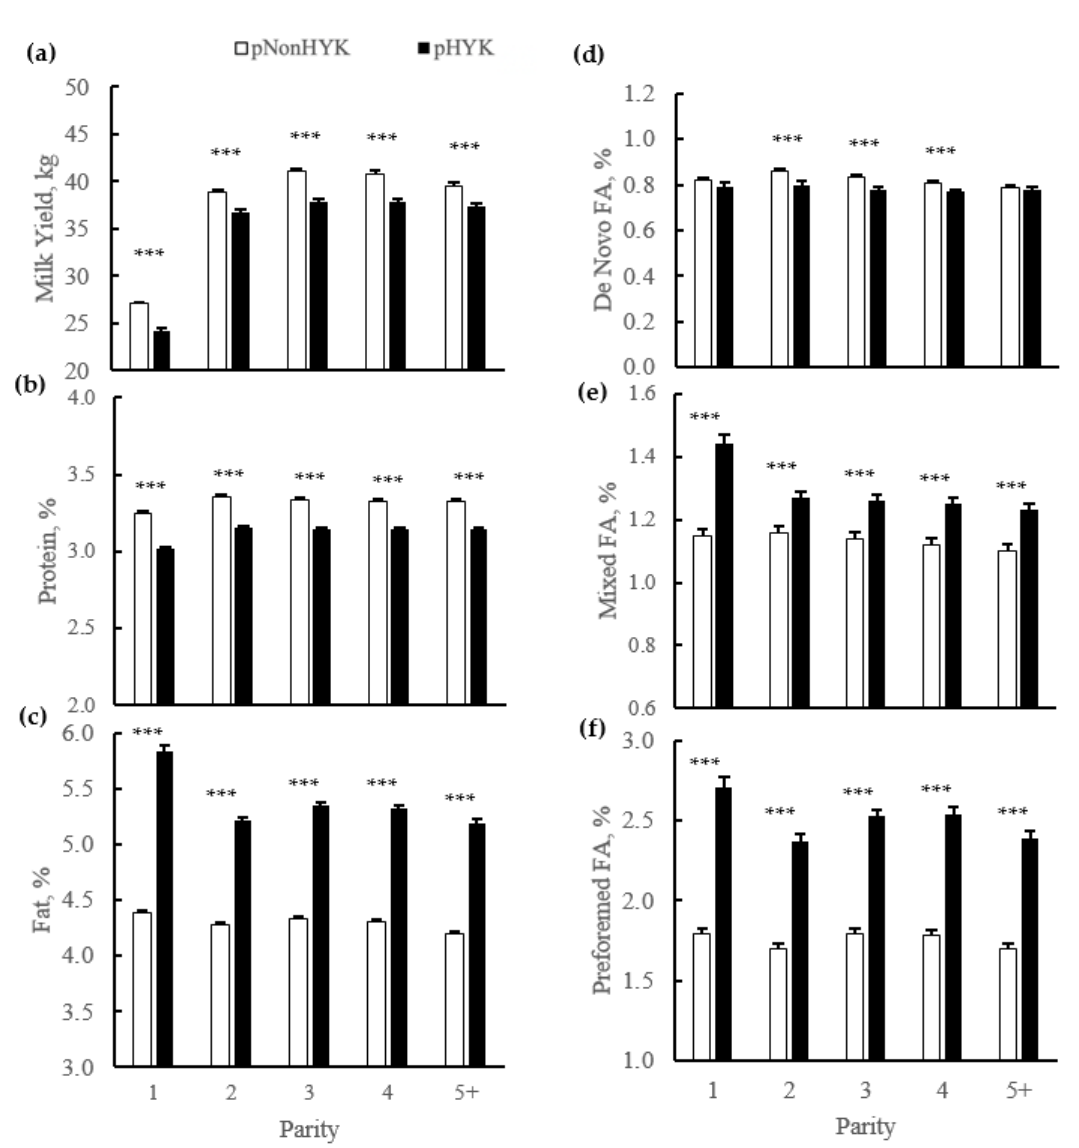
Figure 4. Parity by predicted hyperketonemia (HYK) status interaction on first milk test ( a ) milk yield (kg); ( b ) protein (%); ( c ) fat (%); ( d ) de novo fatty acids (FA; %); ( e ) mixed FA (%); and ( f ) preformed FA (%). Blood ß-hydroxybutyrate (BHB) was predicted based on test day milk sample and production variables collected between 5 to 20 days in milk. Predictions were classified as predicted HYK (pHYK; predicted BHB > 1.2 mM) or not (pNonHYK; predicted BHB < 1.2 mM) for analysis. Records per lactation: 1, 88,782; 2, 67,327; 3, 43,790; 4, 23,999; 5+, 16,816. Predicted HYK, p < 0.001; parity, p < 0.001; parity by predicted HYK interaction p < 0.001 for all panels. Symbols indicate simple effect of classification (***, p < 0.001) within parity.